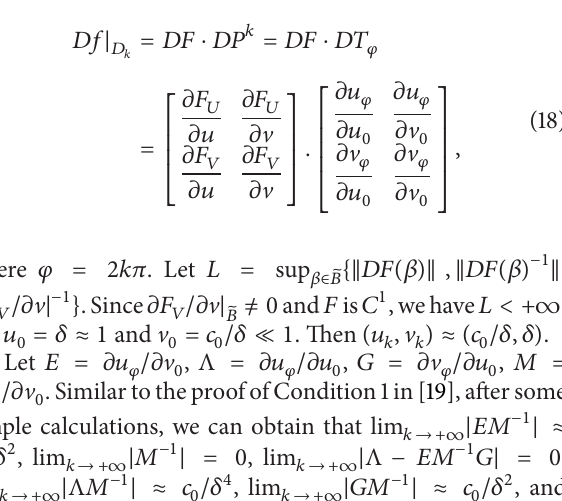
Figure 1: The relation between 𝐷 𝑘 and